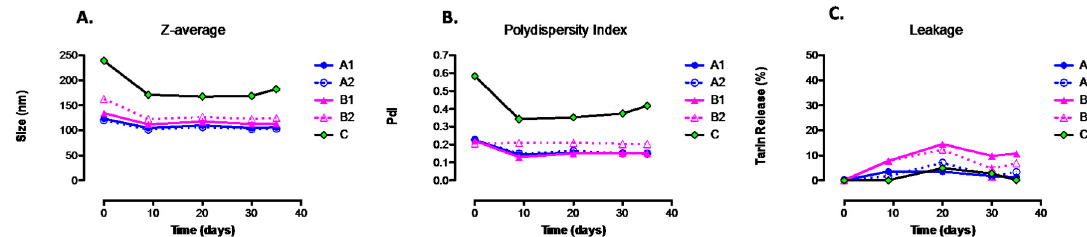
Figure 2. Physicochemical characterization and stability evaluation of liposomal of tarin formulations. The Z-average ( A ), polydispersity index ( B ) and leakage ( C ) of liposome preparations storage at 4 °C were monitored for 40 days. A1, A2, B1, B2, and C represent distinct liposomal encapsulation formulations, presented in Figure S1.